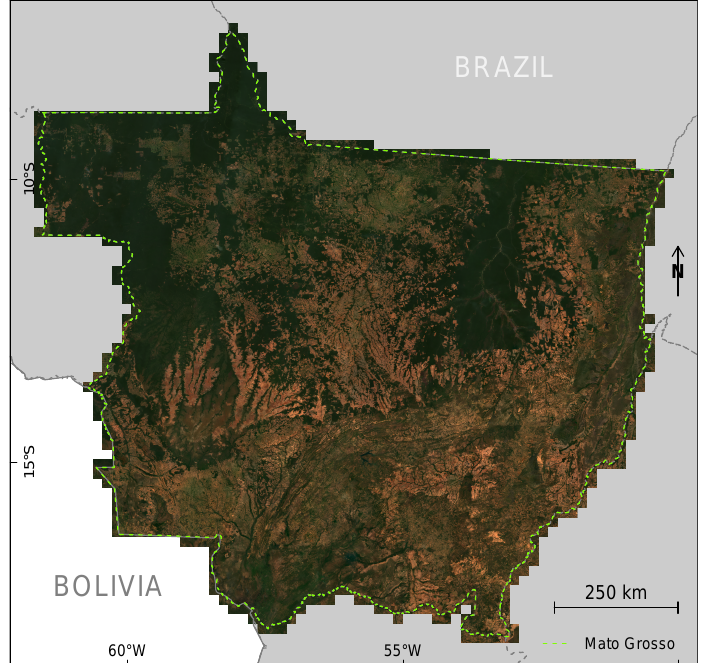
Figure 1. September 2021 planet NICFI mosaic of the Mato Grosso state,